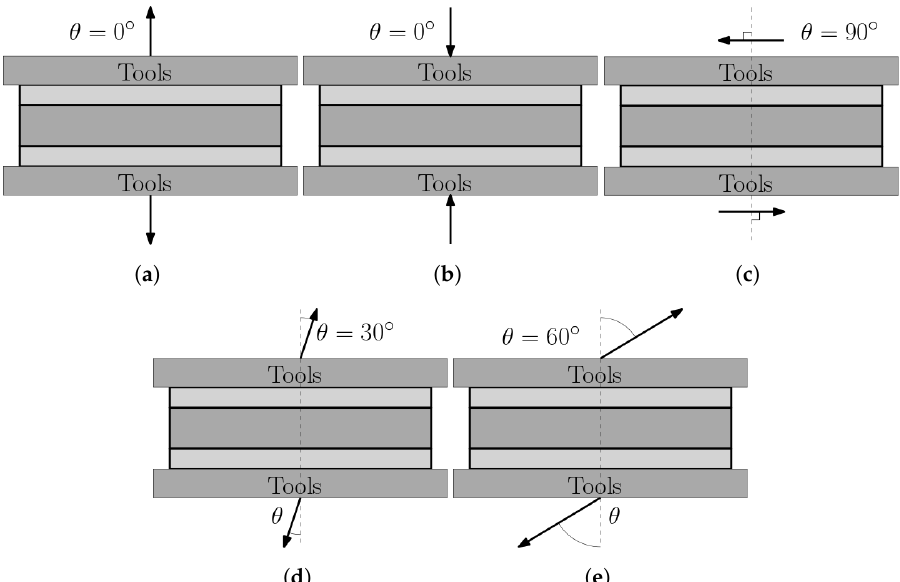
Figure 2. A conceptual illustration of the five LCs used for mechanical characterization of the micro-sandwich core are presented. Arrows indicate the direction of displacement. In ( a – c ) LCs 1–3 are depicted, corresponding to homogeneous, equivalent states of stress. In ( d , e ), LCs 4 and 5 are presented, corresponding to combinations of tensile and shear